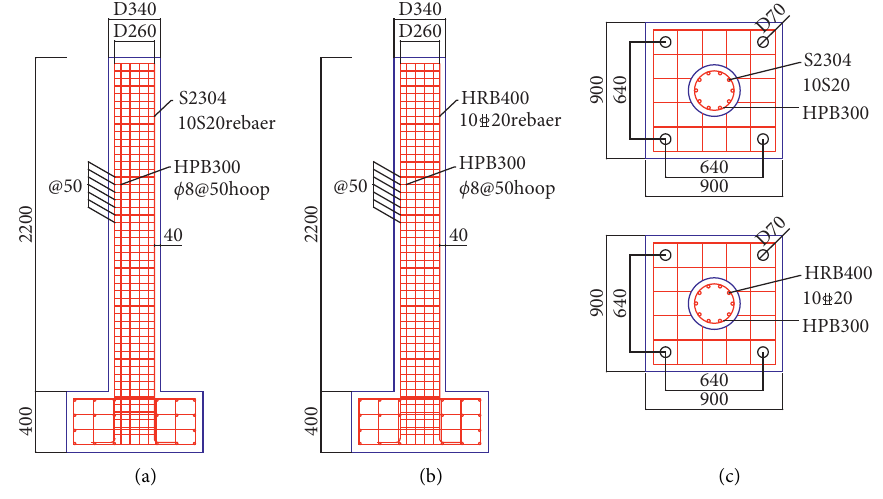
Figure 1: Schematic diagram of the specimen (dimension unit: mm).